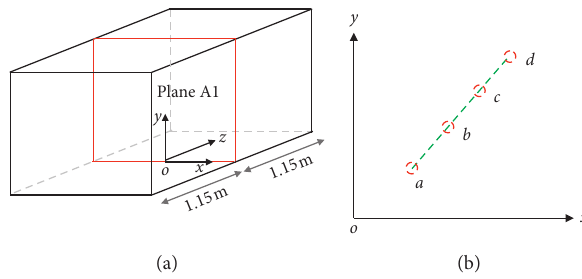
Figure 7: Diagrams of selected plane and points: (a) selected plane; (b) selected